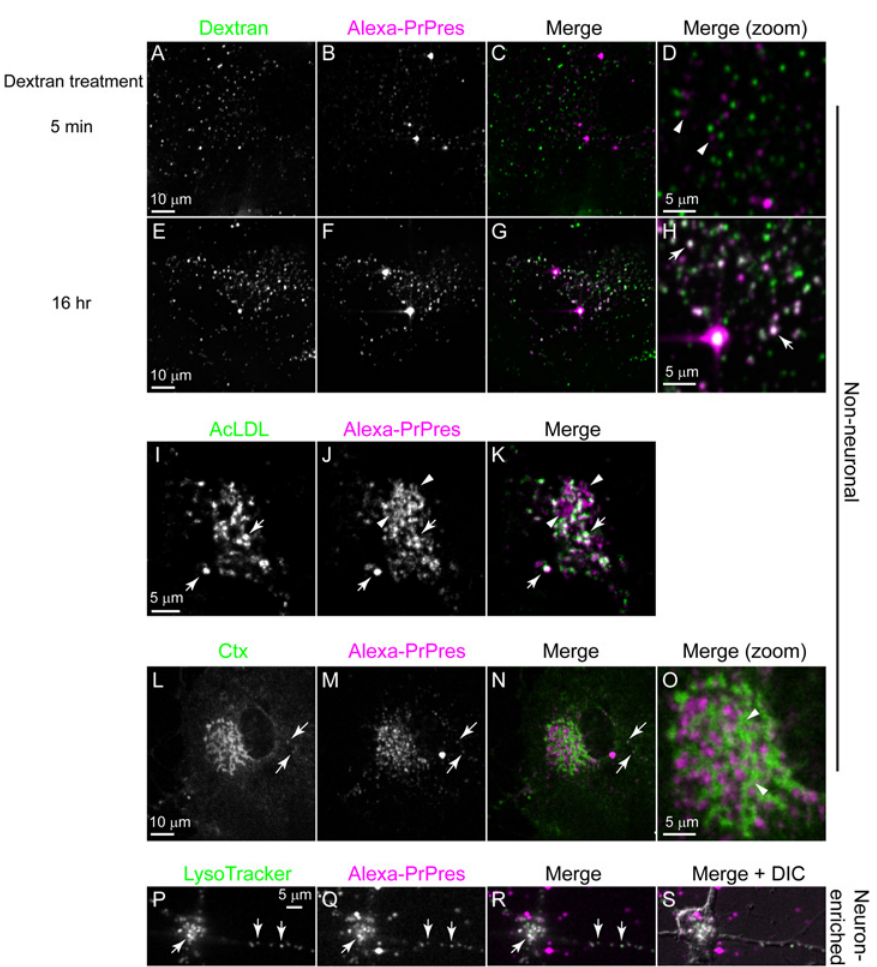
Fig 10. Internalized PrPres is trafficked to late endosomes/lysosomes. Neuron-enriched or non- neuronal cultures containing cells with internalized 263K A647 (B, F, J, M and Q) were incubated with the following markers: Dextran A488 for 5 minutes (A) as a marker for early endosomes or 16 h (E) as a marker for late endosomes/lysosomes; AcLDL (I) as a late endosomal/lysosomal marker in fibroblasts; Ctx (L) as a marker for rafts; and LysoTracker (P) as a marker for acidic organelles. Arrows indicate areas of co- localization. Arrowheads indicate areas without co-localization.